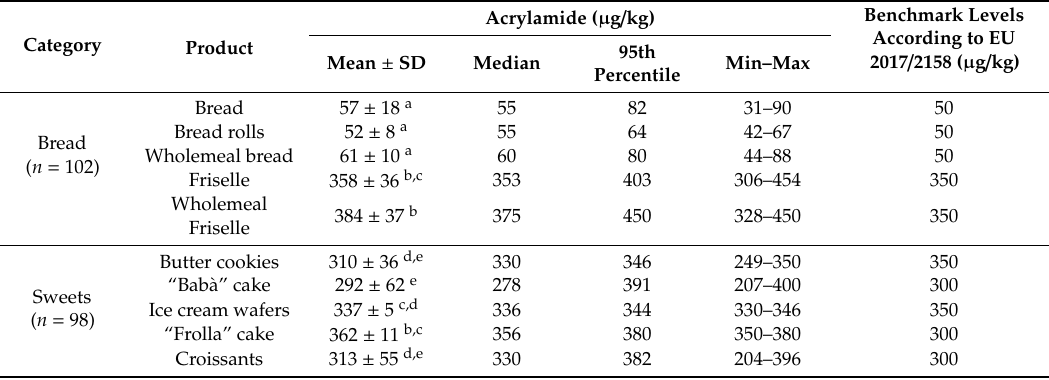
Table 1. Summary statistics of levels of acrylamide bread and